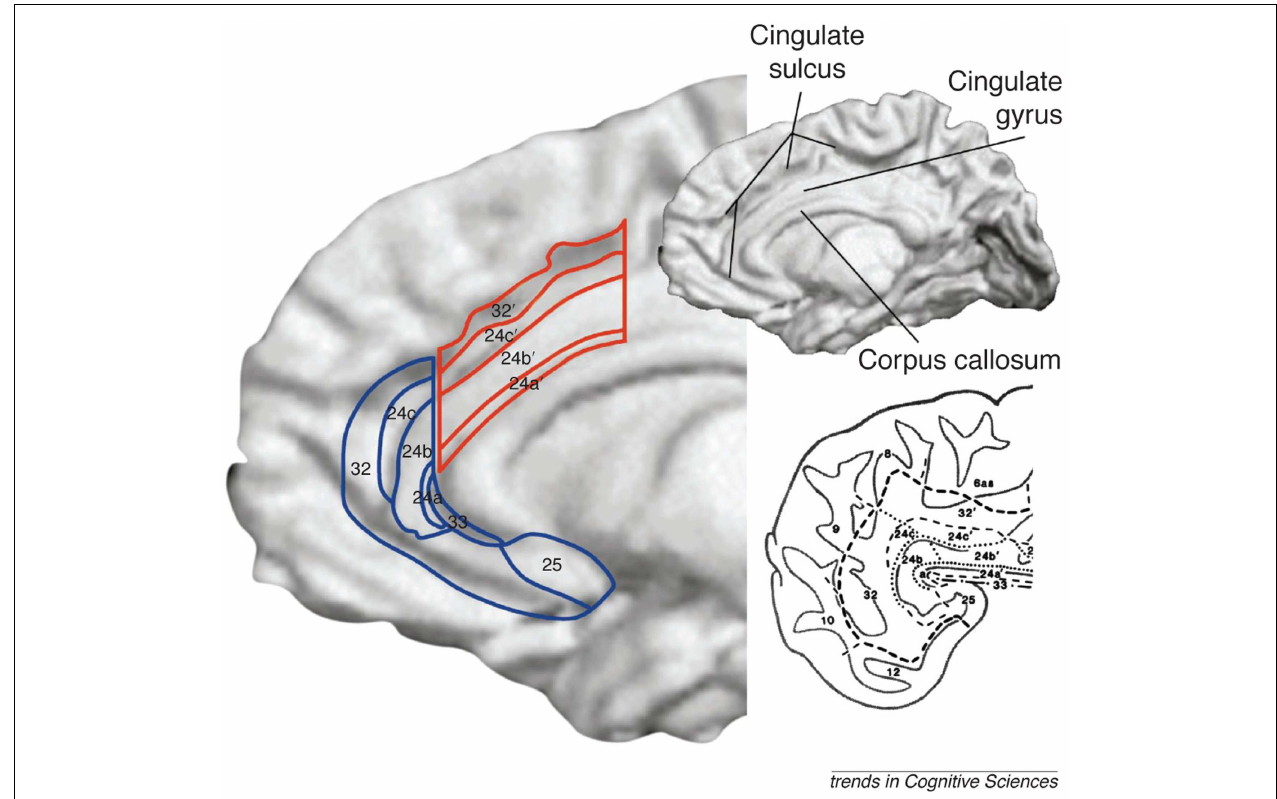
FIGURE 2 |The anterior cingulate cortex (ACC) is subdivided into the dorsalACC (outlined in red), sometimes referred to as the mid-cingulate and the ventralACC (outlined in blue), which can be further subdivided into the pregenualACC (anterior to the genu of the corpus callosum) and